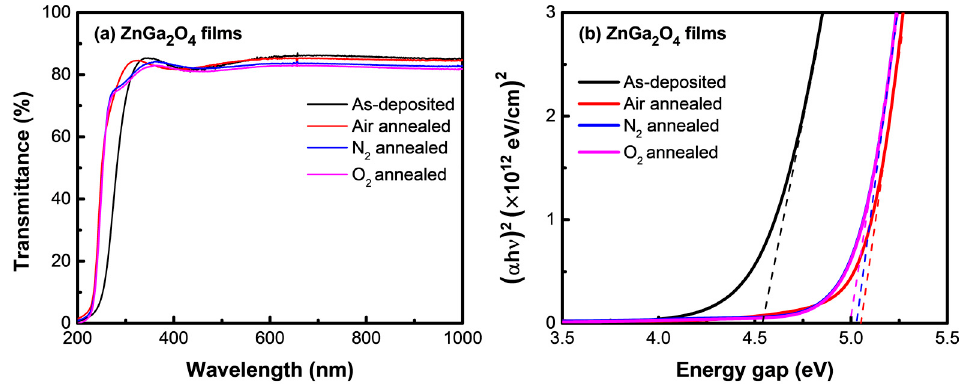
Figure 4. ( a ) Transmittance spectrum and ( b ) Tauc plot of the as-deposited and annealed ZnGa 2 O 4 films under different annealing